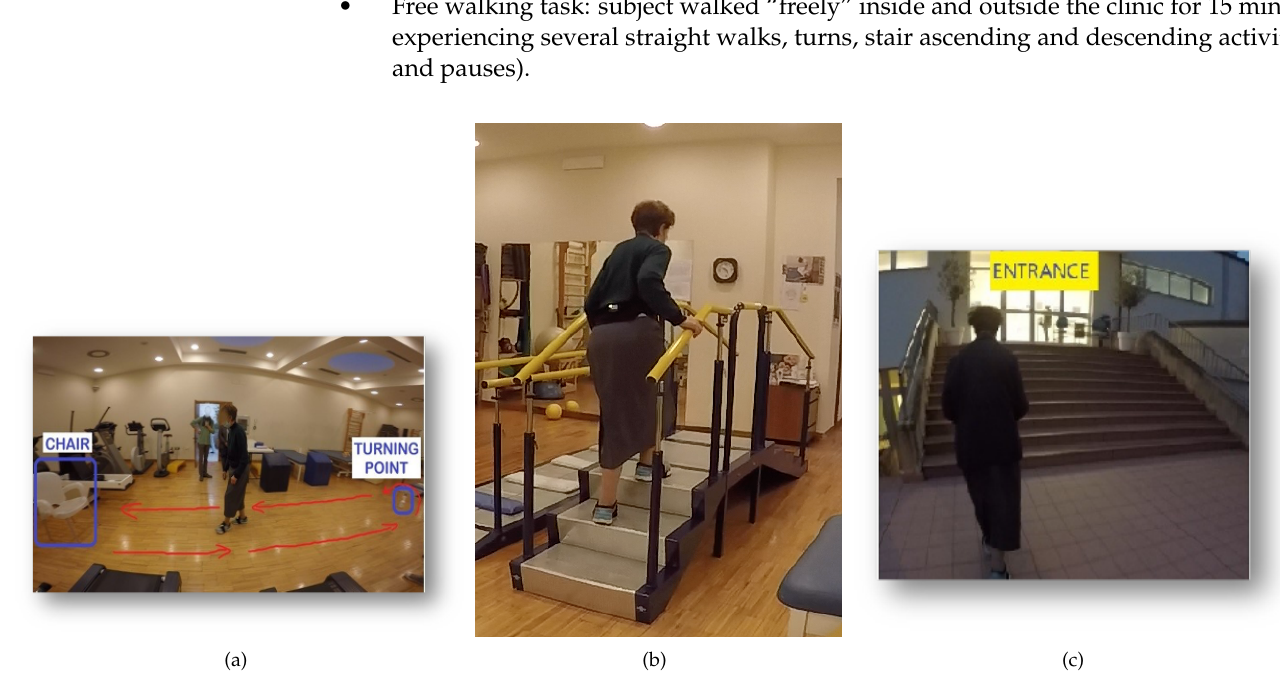
Figure 6. Laboratory trial: ( a ) Timed Up and Go (TUG) task; ( b ) Stair task; ( c ) Free walking